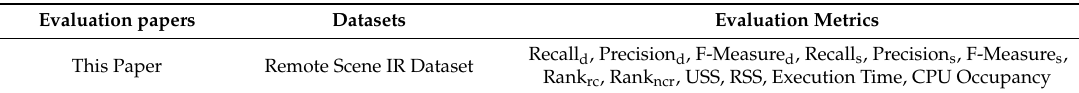
Table 2. All the evaluated BS algorithms were implemented based on Opencv-2.4.9. Table 6. Introduction of this evaluation